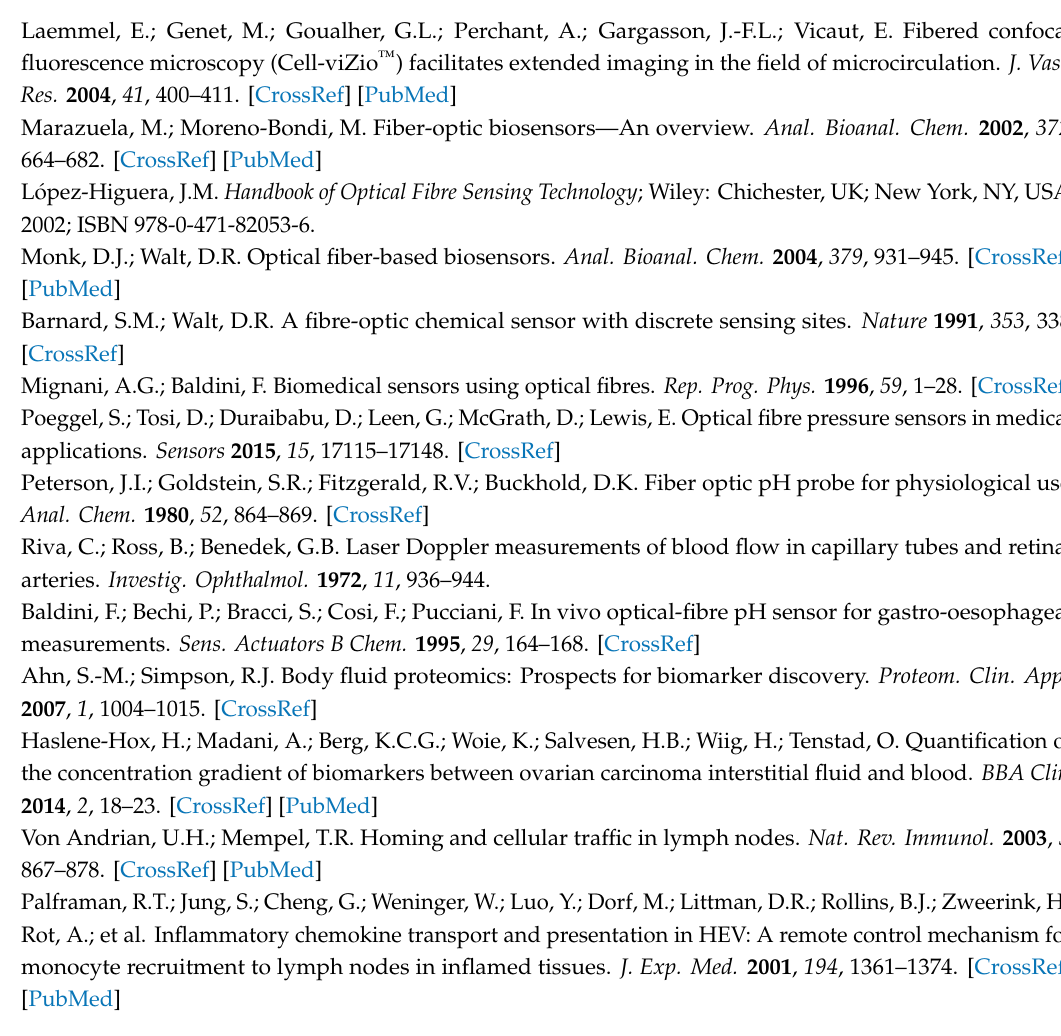
micropillar configuration. In the present study, micropillars with the following characteristics have been fabricated: base diameters d of 2–3 µ m, height h of 7–10 µ m, half apex angle α of 10 ◦ . Figure S2: Principle of measurement of the half apex angle α on a SEM image of a micropillar structured optical fiber bundle. Figure S3: Principle of estimation of the gold thickness on the lateral faces of the micropillars. Figure S4: STL file of the microcantilever. Total dimension of the sample is 20 × 10 × 3.5 mm 3 , Figure S5: Micropillar structures damages caused by previously used silicon cantilevers for optical fiber functionalization. (A) S.E.M image of Bioplume Si cantilever. (B) Optical image of spotting process with Si cantilever. (C) Retro reflected image of the functionalized fiber bundle. (D) S.E.M image of induced